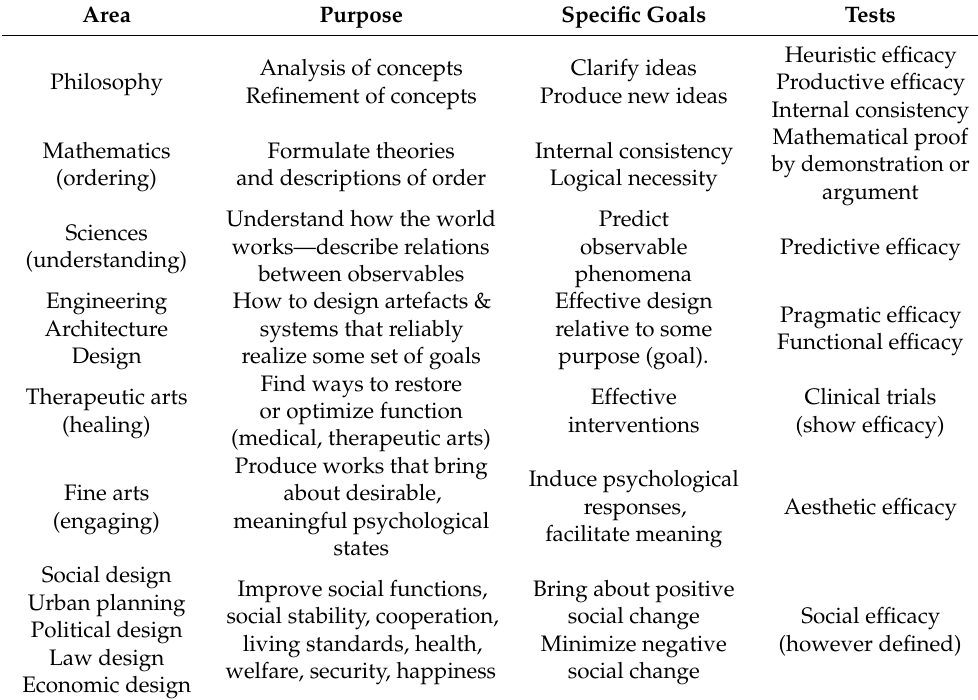
Table 2. Areas of intellectual endeavor, goals, and evaluative